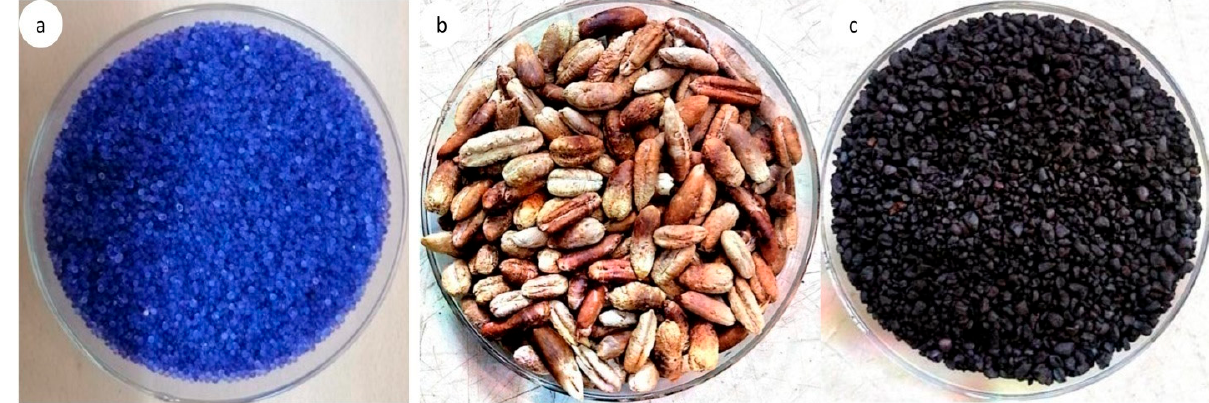
Figure 2. ( a ) Silica gel type III, ( b ) dried date stone and ( c ) activated carbon